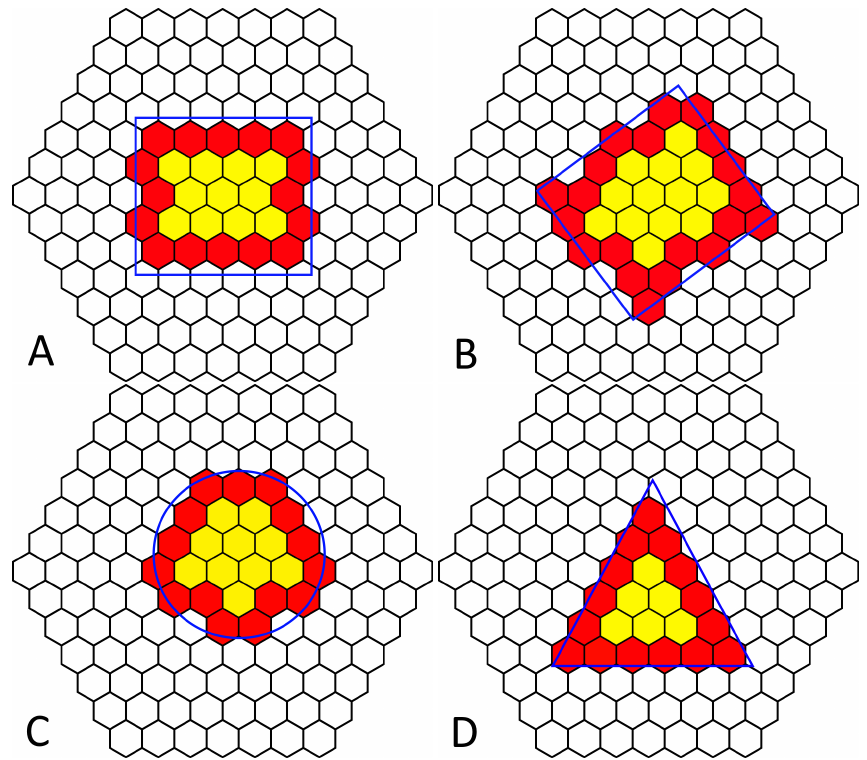
Figure 12. Edge detection of various simple shapes (blue outline) on a tiled hexagonal cilia platform (black). Clear hexagonal cilia are “uncovered”, red are “edge”, and yellow are “interior”